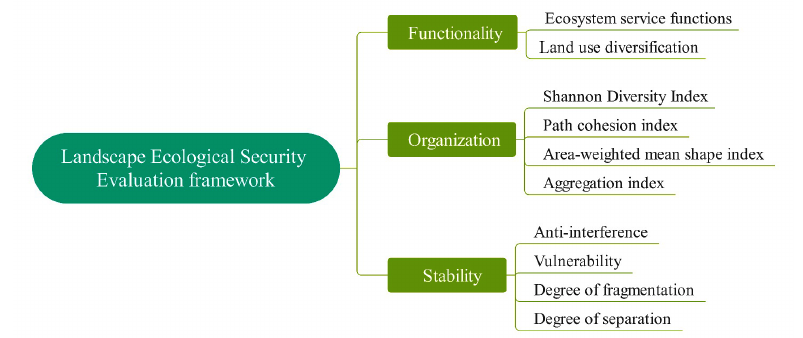
Figure 2. Landscape ecological security assessment framework